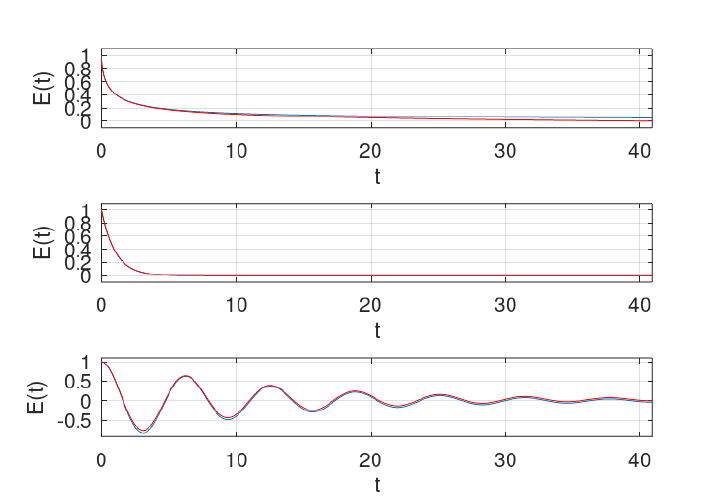
Figure 10. Mittag–Leffler functions for the CT (blue) and DT (red) cases. α = 0.6, 1, 1.9 from top to bottom. T =